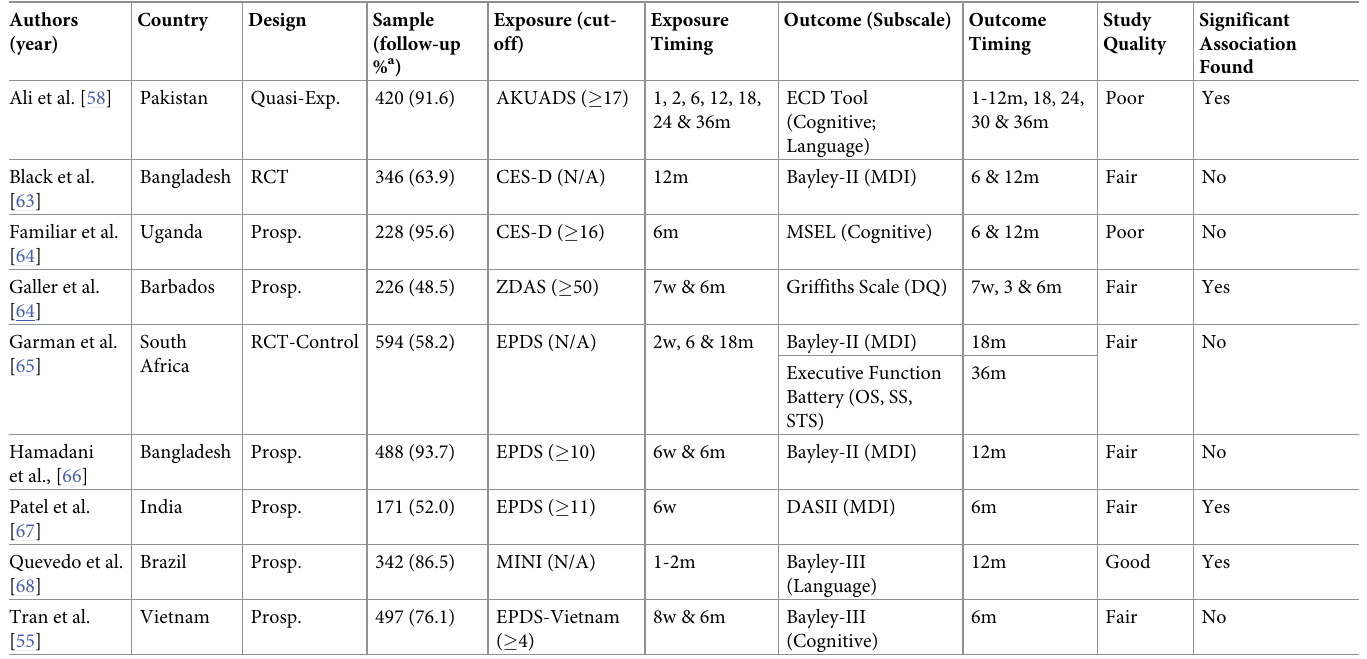
Table 3. Key features of included postnatal studies. Authors Country (year)